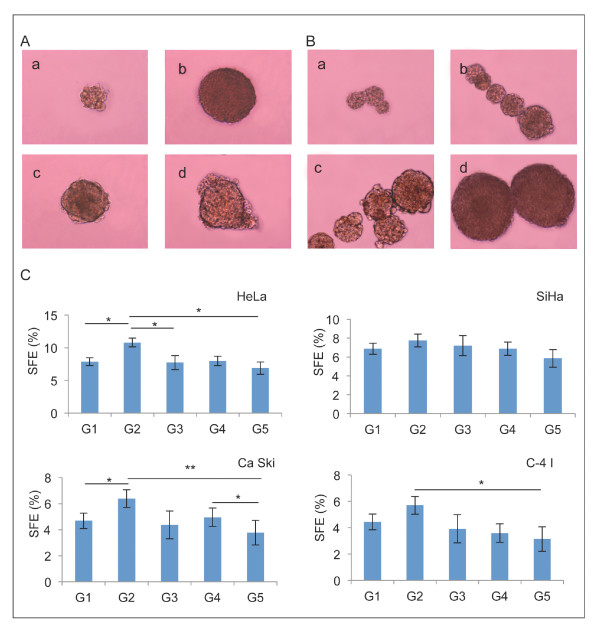
Spheroids of self-renewing cells from established human cell lines of squamous carcinomas and adenocarcinomas of the cervix. A, Morphology of cells cultured in anchorage-independent conditions as non-adherent clusters one week after plating HeLa (a), SiHa (b), Ca Ski (c), and C-4 I (d) cells. Magnification is 10X, size bar = 100 μm. B, Serial photographs during culture demonstrated progressive increase diameter at 4 (a), 8 (b), 12 (c) and 16 days (d). Magnification is 10X, size bar = 100 μm. C, Sphere-forming efficiency (SFE) of spheroid cells on serial passage from first to fifth generation (G1-G5). Cells were plated at a density of 100 cells/well in 200-μl of serum-free medium (SFM), spheres were counted weekly. Bar graph represents the SFE mean calculated by counting the number of spheres formed in a given well and dividing by the total number of cells seeded in the well, represented as a percentage. Error bars represent standard deviation (SD) (n = 3); * p < 0.05 and ** p < 0.005